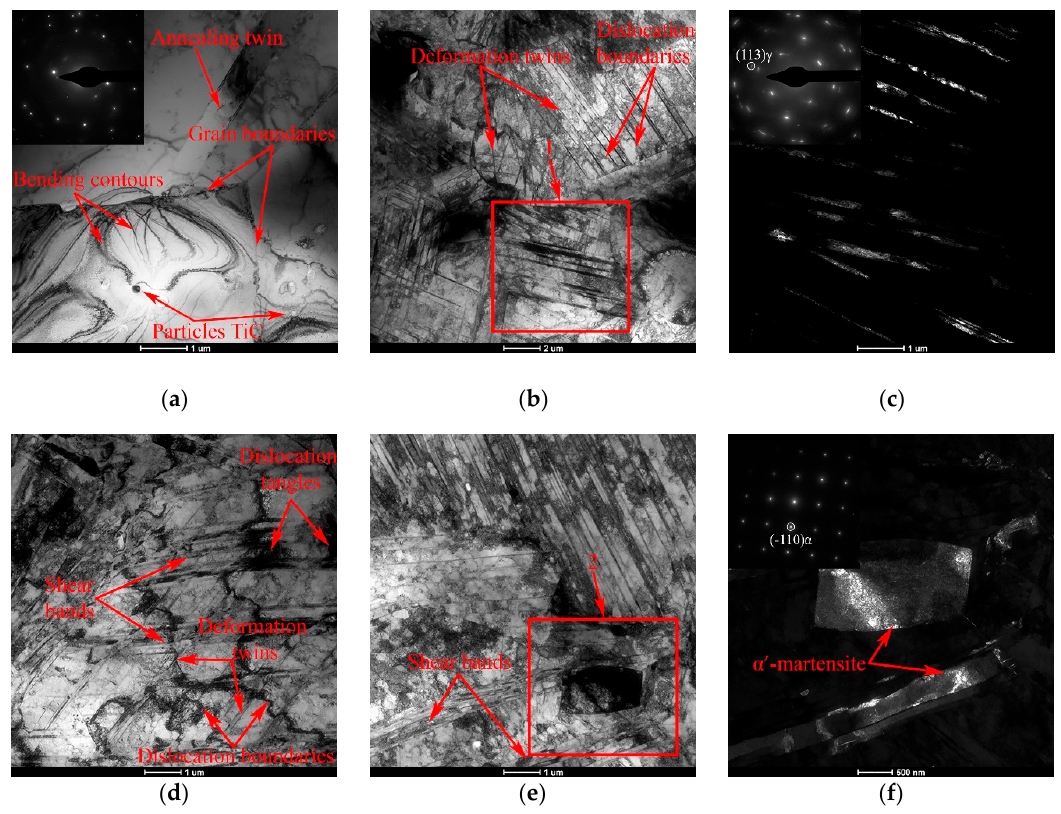
Figure 1. The TEM micrographs of the 321 MASS in the cross section of the rod in the initial state ( a ), after deformation with degrees of e = 0.26 ( b , c ) and e = 0.56 ( d – f ): ( a , b , d,e ) Bright-field images; ( c ,f) Dark-field images from sections 1 and 2 in the reflections (131) γ and ( − 110) α , respectively.